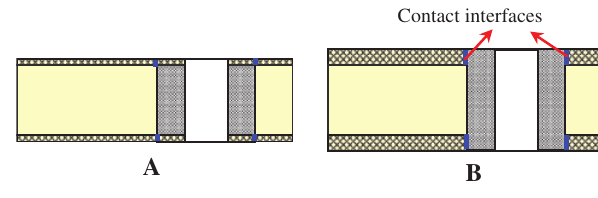
Figure 13 Schematic of the through-thickness contact surface between the potting material and face sheets: (A) for small face- sheet thicknesses and (B) for larger face-sheet